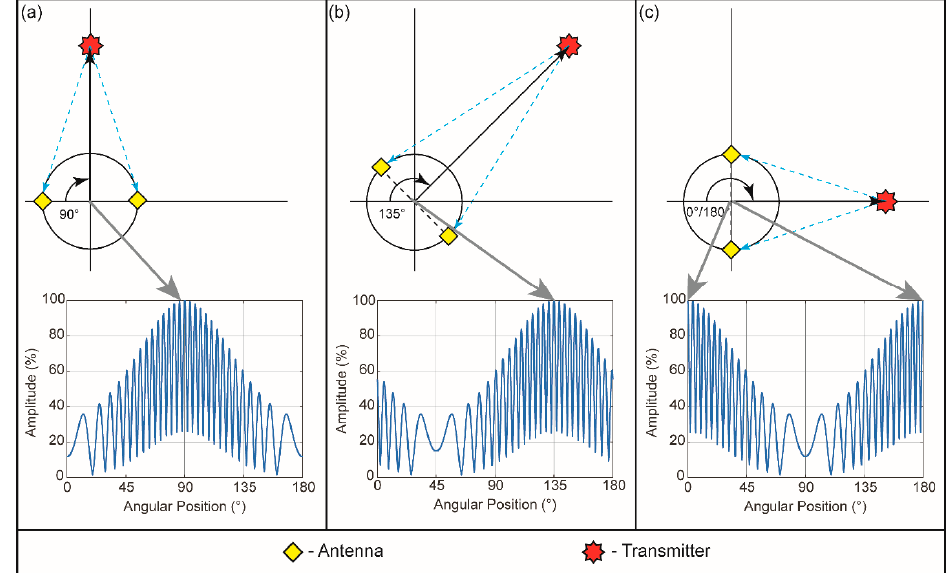
Figure 3. Spatial geometry of a single sensor with two antennas at the selected locations and the sensor’s signal response for one-half revolution ( not to scale ). The central peak of the signal shape represents the direction used for the narrow search. The three selected transmitter positions shown are: ( a ) 90° with respect to the coordinate system; ( b ) 135° with respect to the coordinate system; and ( c ) 0°/180° with respect to the coordinate system. In all cases, the distance between the center of the sensor and the transmitter was 2 meters in the horizontal plane and 1 meter in the vertical plane.